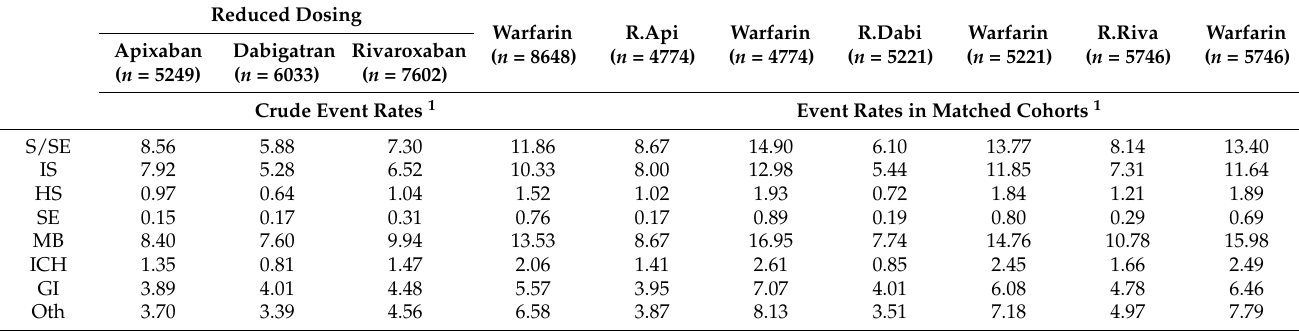
Figure 2. Event rates and hazard ratios in propensity score-matched cohorts for the comparison of reduced-dose NOACs with warfarin. Table 3. The summary of crude event rates in patients taking reduced-dose NOACs and warfarin.